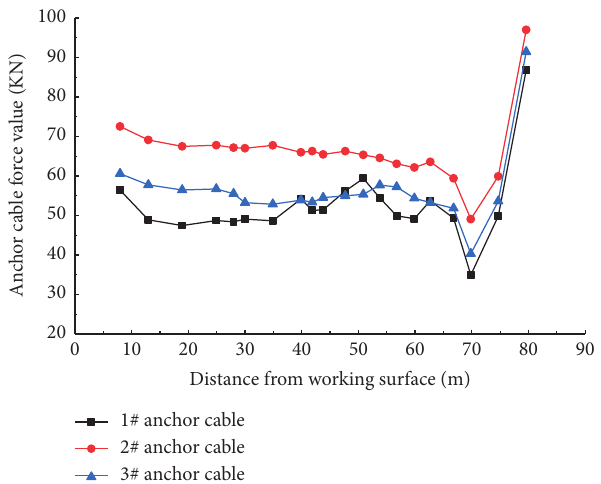
Figure 12: Stress characteristics of roof anchored cable in air- return roadway 5103.